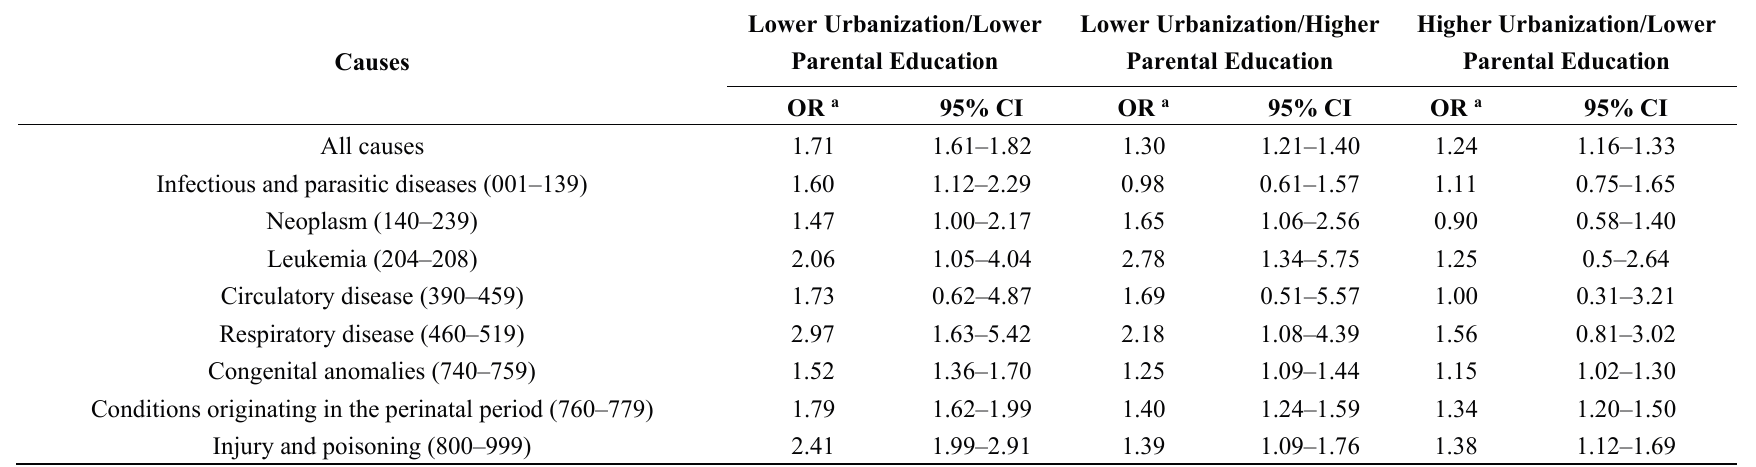
Table 4. Covariate adjusted all causes and cause-specific odds ratio of <5 mortality associated with various disadvantageous groups (Reference group: Higher urbanization/higher parental